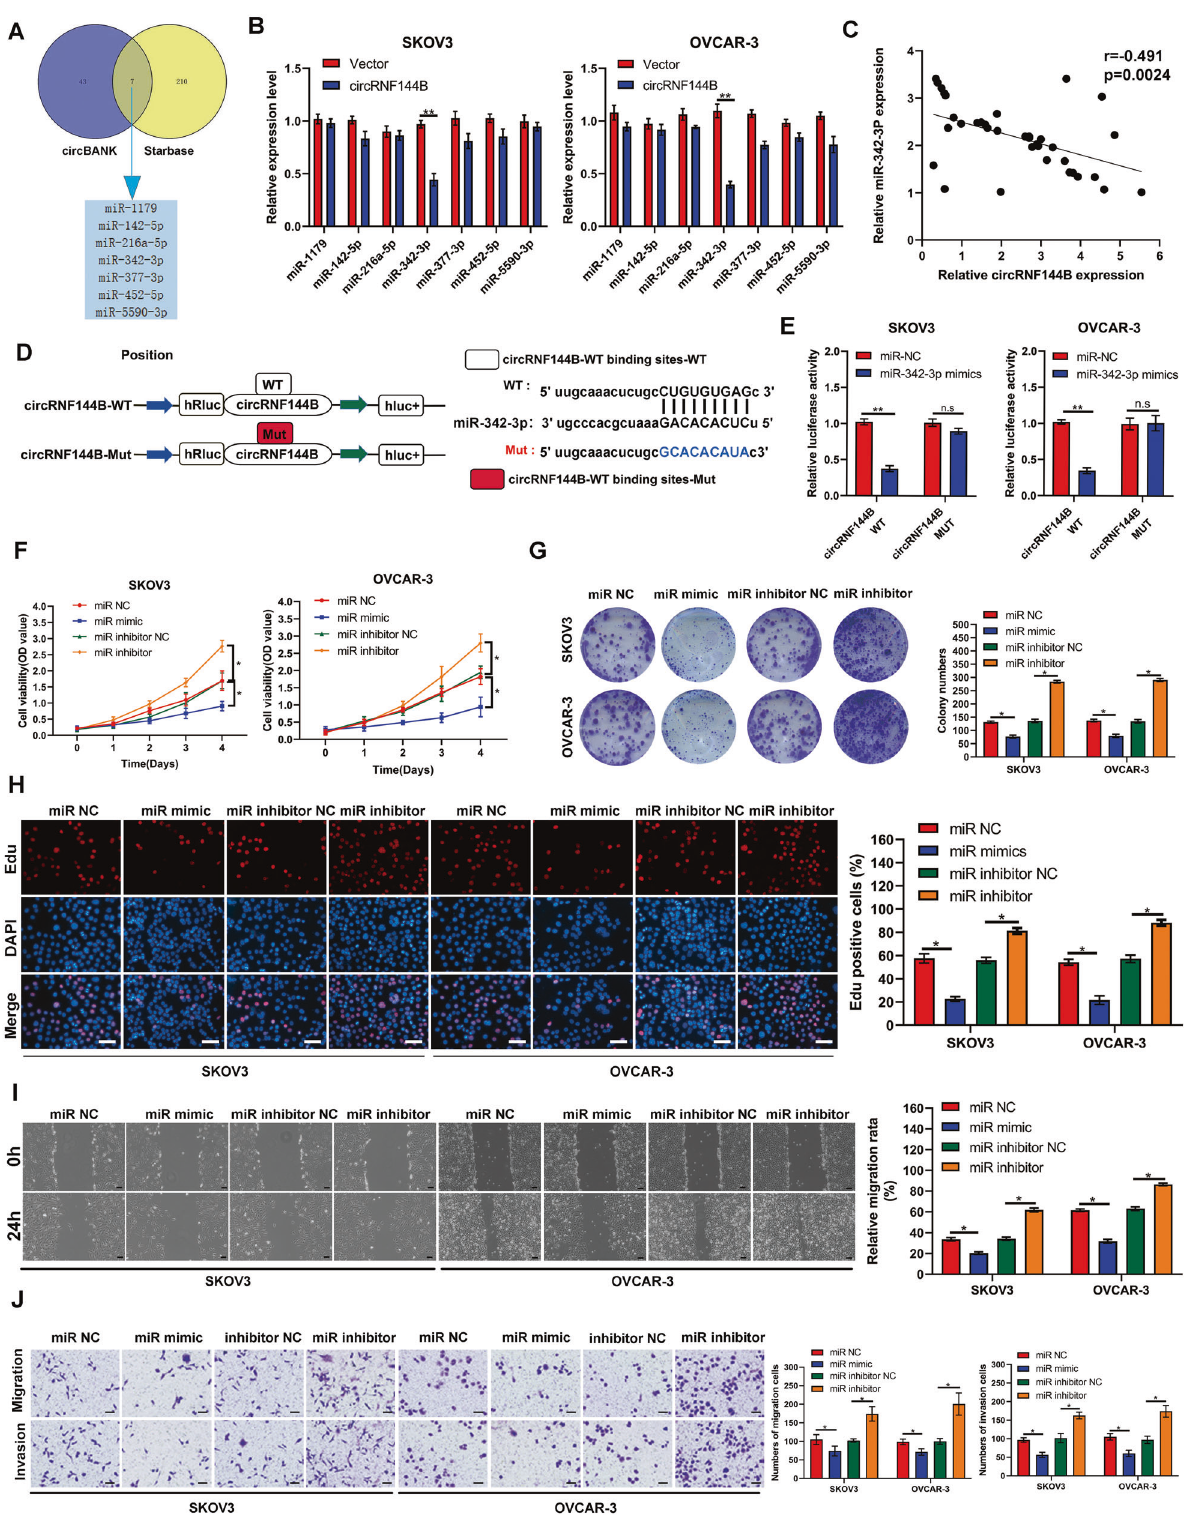
normal ovarian epithelial cell line IOSE80 (Fig. 1K). Moreover, the clinicopathological characteristic analysis found that circRNF144B- High was associated with lymph node metastasis in OC patients (Supplementary Table 2). In conclusion, circRNF144B was found to